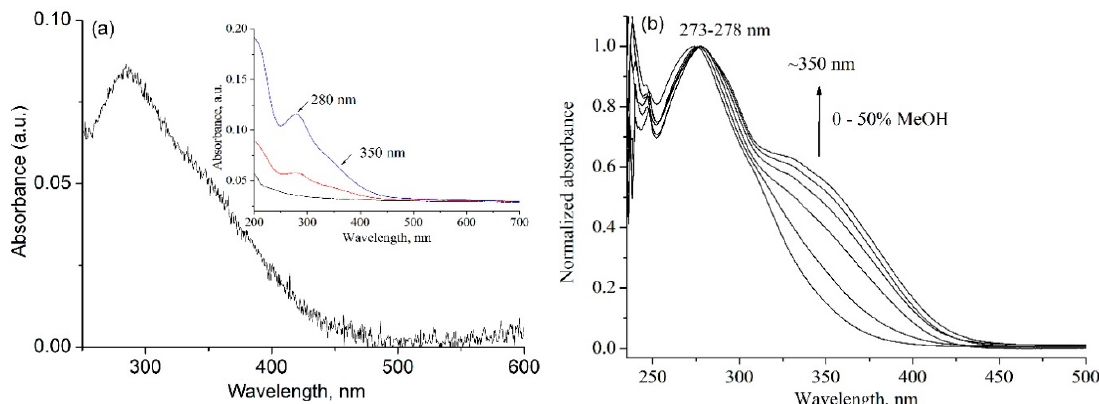
Figure 10. ( a ) Reflection-absorption spectrum of compound 3 at the air–water interface at the surface pressure of 20 mN/m (inset, UV/Vis spectrum of quartz (black line) and compound 3 in 1 (red line) and 5 (blue line) monolayers on quartz substrate; ( b ) UV/Vis spectral changes upon addition of up to 100% of MeOH solvent to chloroform solution of nitrocalixarene 3 .